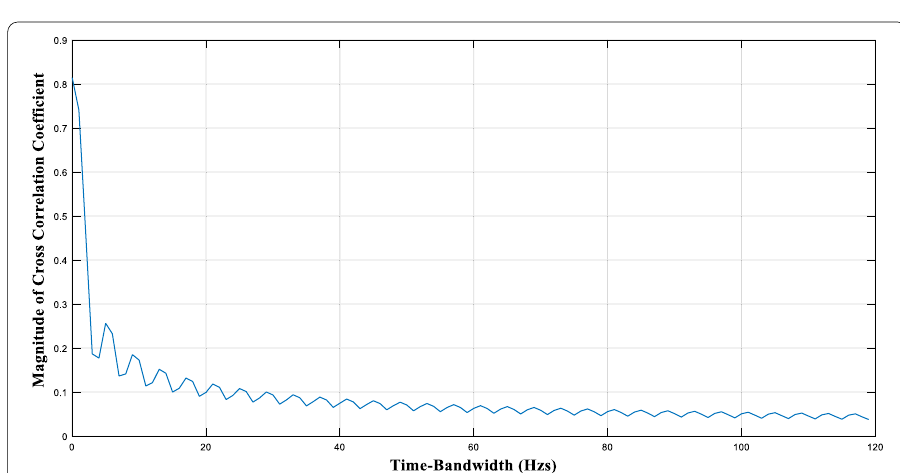
Fig. 2 Time bandwidth versus cross-correlation coefficient